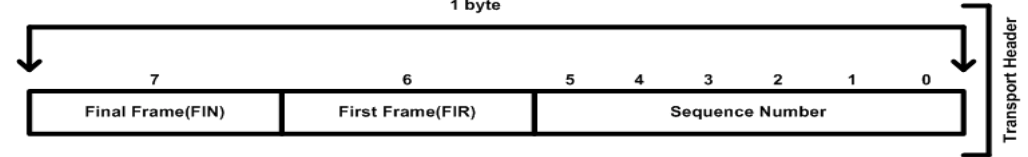
Figure 6. Transport header field structure.